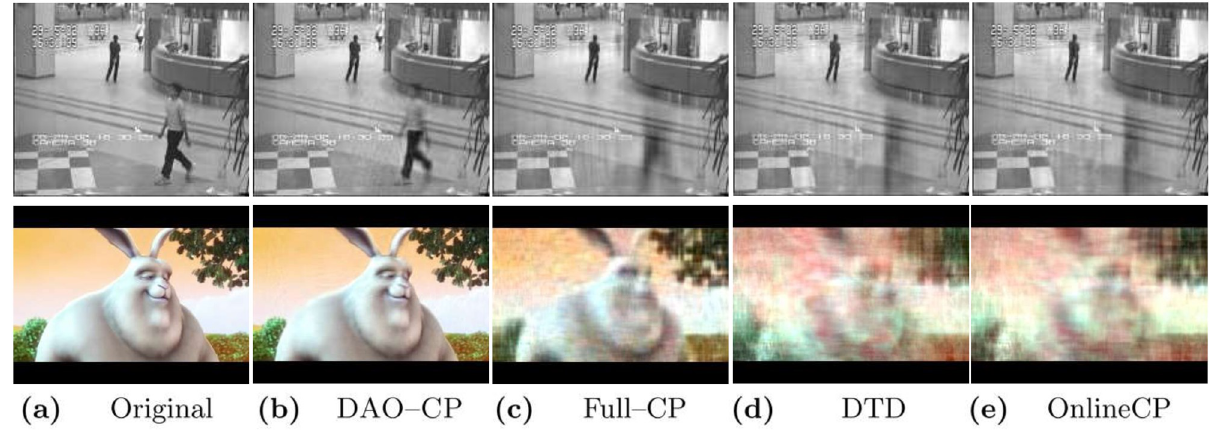
Fig 1. Accuracy comparison between DAO-CP (proposed) and its competitors on Airport Hall (upper) and Sample Video (lower) datasets. DAO-CP automatically detects a change of theme (for example, an object starts moving or a scene changes) and re-decomposes the data depending on the degree of changes. Note that DAO-CP results in much more clear images than the competitors with little sacrifice in